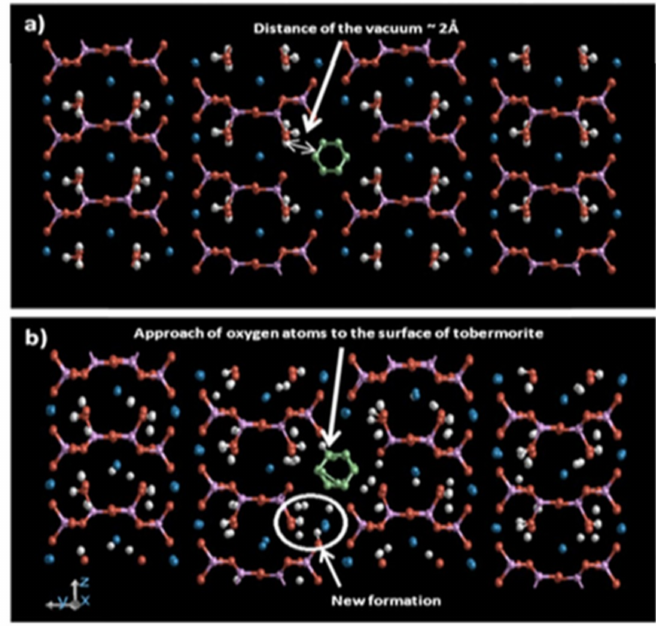
Figure 13. Snapshot of the CNT / C–S–H system: ( a ) CNT’s insertion into the hole of C–S–H and ( b ) formation of new morphology. Reproduced from [95], with permission from Elsevier,